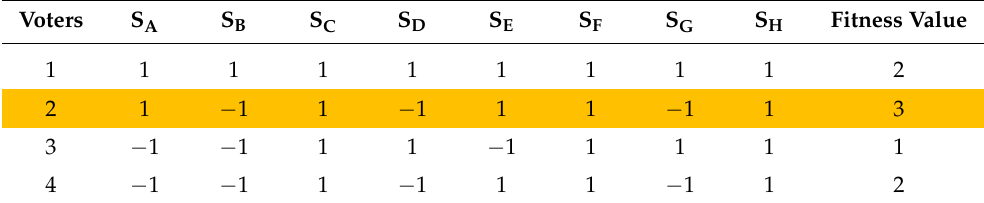
Table A1. Calculation of voters and Candidate of a Party